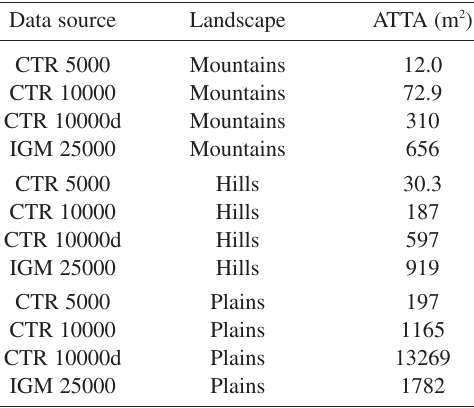
Table II. The Average TIN Triangle Area (ATTA) for different data sources and different landscapes. Data source